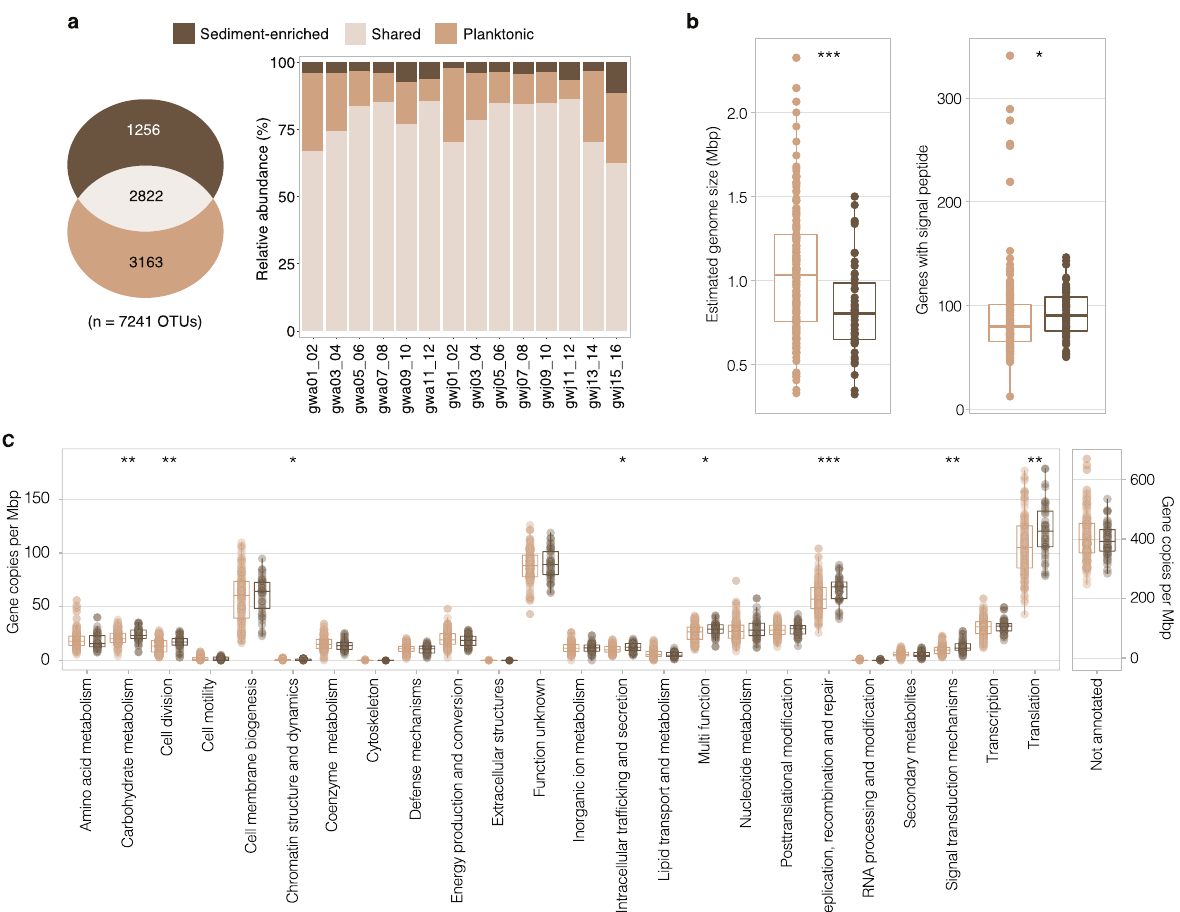
Fig. 6 Planktonic and sediment-enriched ultra-small microbial fractions in aquifers. a Venn diagram comparing planktonic and sediment- attached ultra-small microbial communities based on the presence/absence of related 16S rRNA OTUs (left) and relative abundance of each fraction (right). b Difference in estimated genome size and genes containing predicted signal peptides between ultra-small MAGs enriched in the planktonic and sediment-enriched aquifer fractions. c Gene copy numbers across metabolism in planktonic and sediment-enriched associated ultra-small MAGs. Copy numbers were normalized to estimated genome size. Meaning of box-plot elements described above. Statistical signi fi cance was assessed using Wilcoxon Signed Rank (* p < 0.05, ** p < 0.01; *** p <